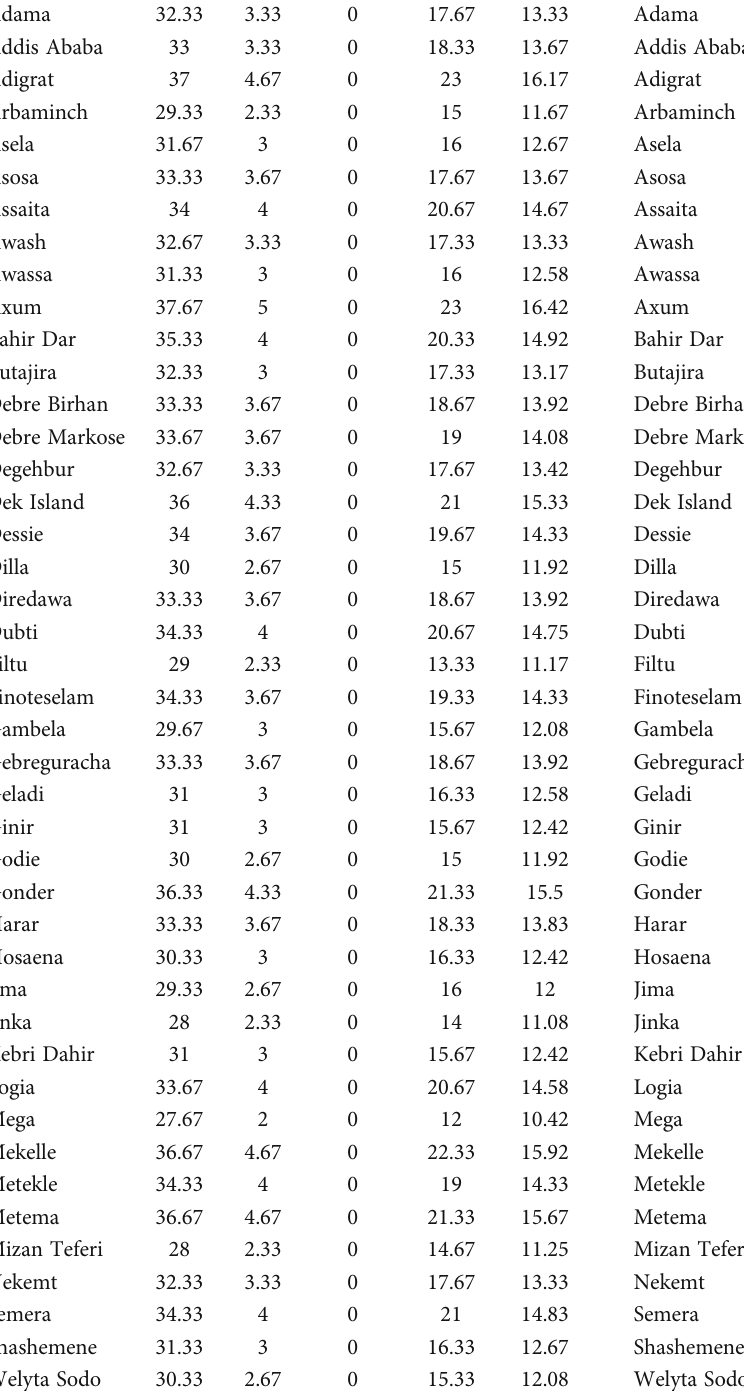
Table 4: The seasonal and yearly optimal tilt angle of 44 cities in Ethiopia using the anisotropic model, equation (19).